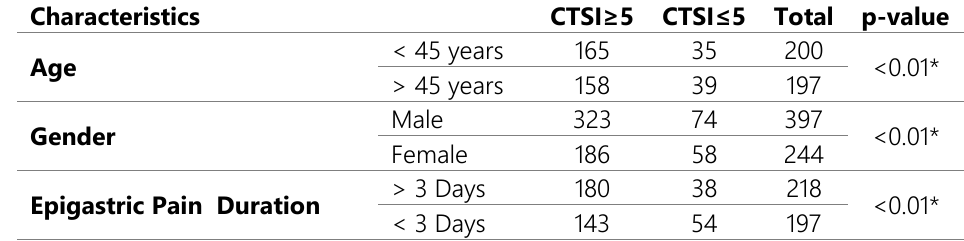
Table 2: Comparison of CTSI score with patient